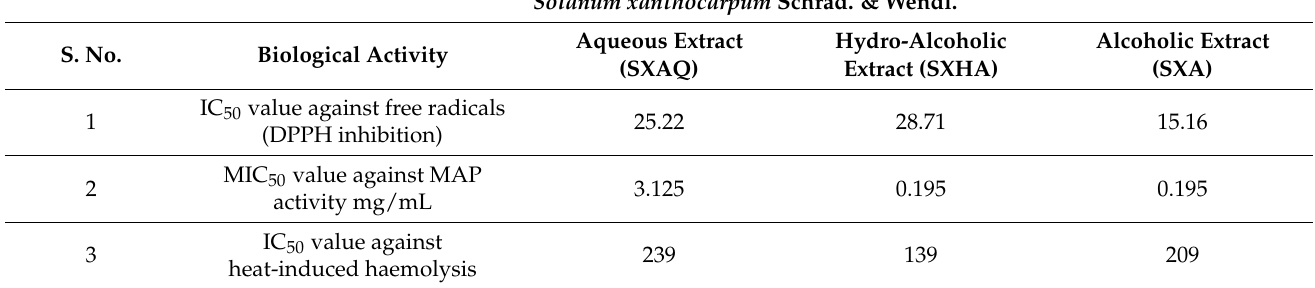
Table 1. In vitro pharmacological analysis of aqueous, alcoholic and hydroalcoholic extracts of Solanum xanthocarpum Schrad. & Wendl.